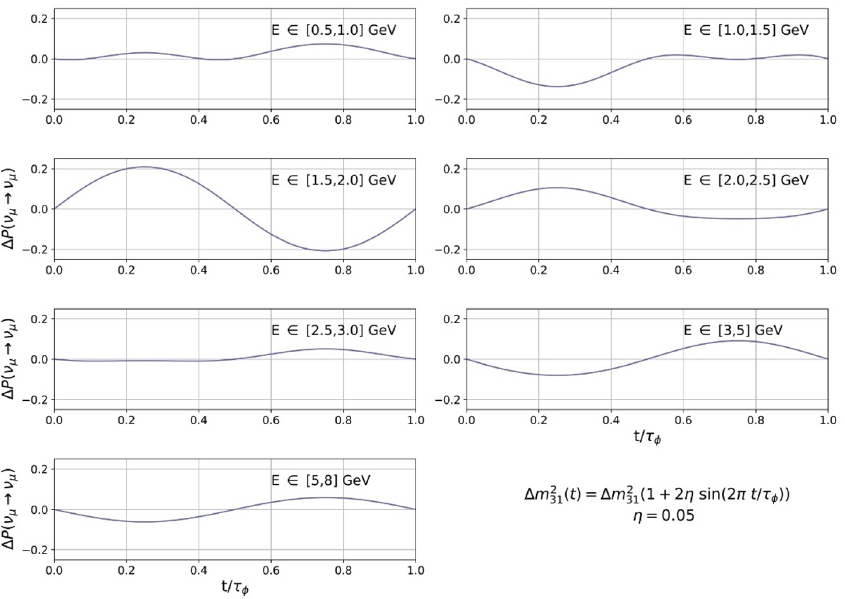
Figure 2 . The difference in ν µ disappearance oscillation probability ∆ P ( t ) ≡ P µµ ( t ) − P µµ (0) at DUNE for a modulating ∆ m 2 assuming η = 0 . 05 for several energy bins. We have assumed 31 normal mass ordering and the best fit values of oscillation parameters from ref. [44], namely ∆ m 2 2 . 5 × 10 − 3 eV 2 , and sin 2 θ 23 = 0 . 55